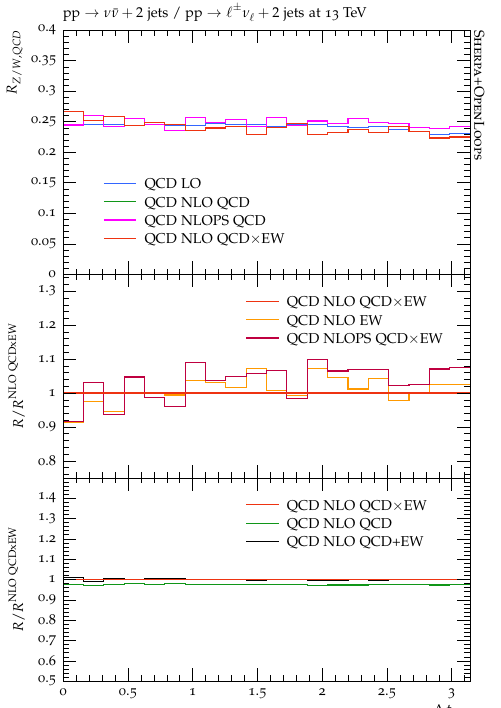
Figure 13. Ratios of the QCD pp → Z ( ν ‘ ¯ ν ‘ )+2 jets and QCD pp → W ± ( ‘ ± ν ‘ )+2 jets distributions in ∆ φ j . The same higher-order predictions and conventions as in figure 12 are used. 1 j 2